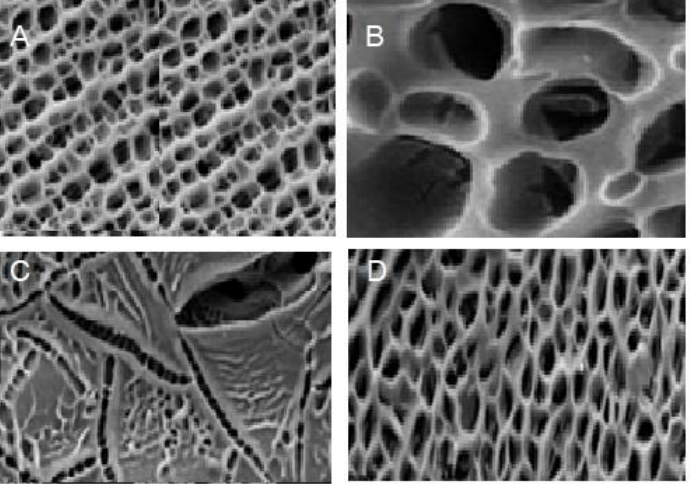
Figure 5. SEM images of lyophilized ( A ) DMAPM AAm hydrogel and ( B ) DMAPMAAm/nano-SiO 2 , ( C ) DMAPMAAm/amine-modified hydrophilic nano-SiO 2 , and ( D ) DMAPMAAm/EP nanocomposite hydrogels.